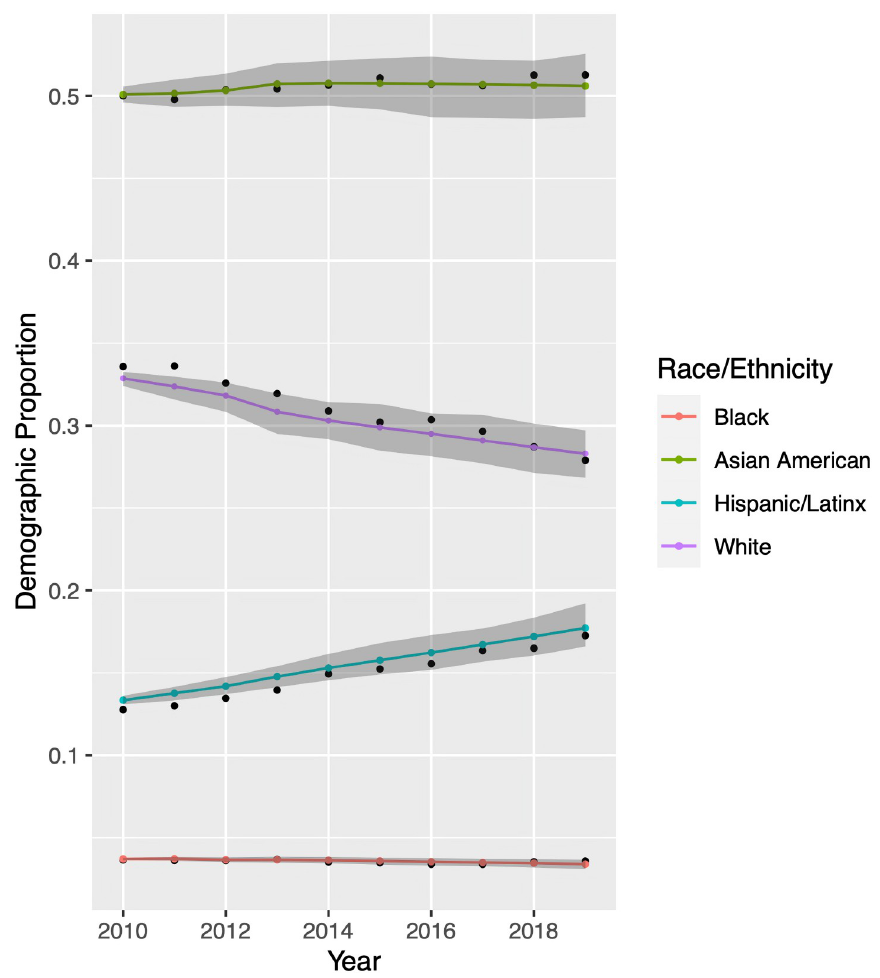
Fig 5. Model validation for University of California-Berkeley. Historical enrollment records appear as black dots. Colored dots are model output obtained when using the parameters forecast in Inferring Model Parameters. We perform an additional 2800 model simulations using parameter sets generated by Latin hypercube sampling. Grey bands indicate the central 95% of these results. Demographic proportions are relative to each other; see Mathematical